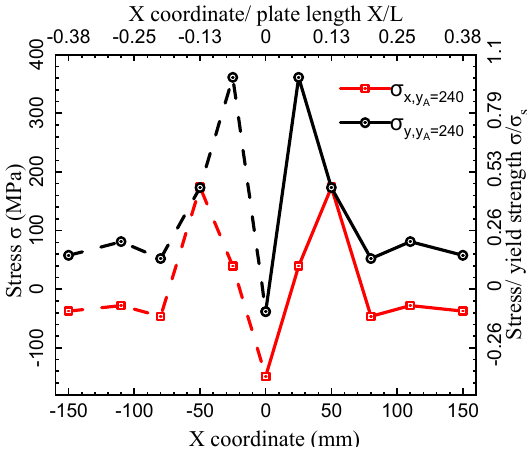
. Figure 20. The stress on path L (cid:3250) (cid:2880)(cid:2870)(cid:2872)(cid:2868) yA = 240